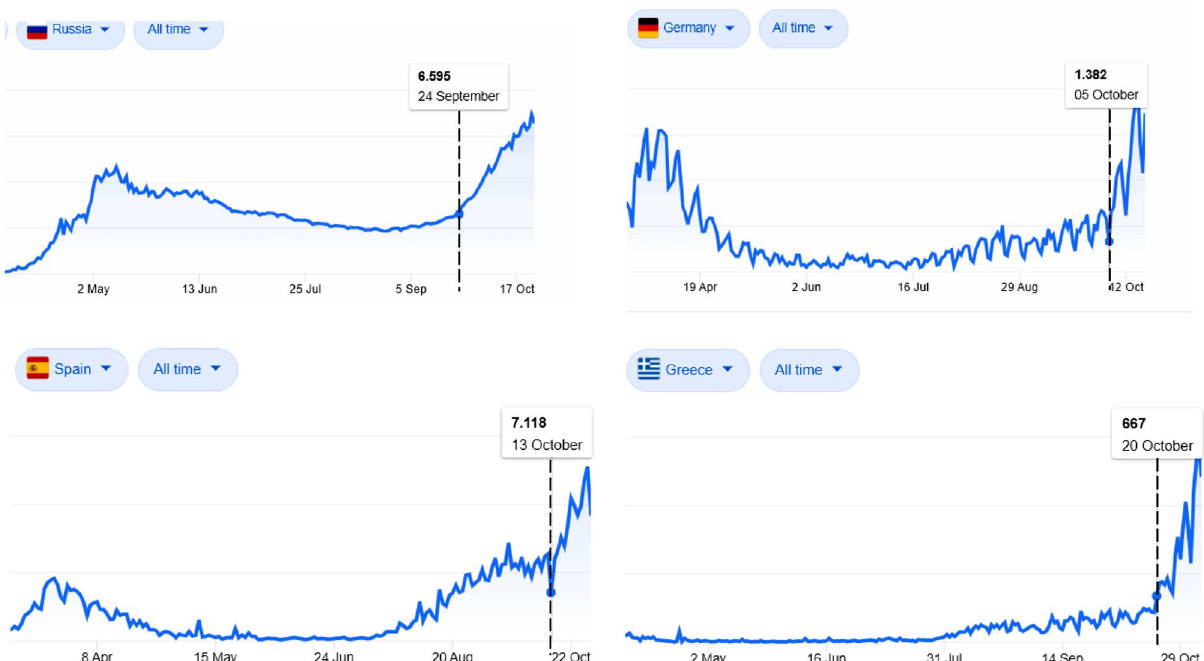
Figure 1. Typical examples of daily new COVID-19 cases (extracted from the statistics panel of the Google home page when searching “COVID” at www.googl e.com, last accessed 8th November 2020). All curves exhibit a clear surge in the growth